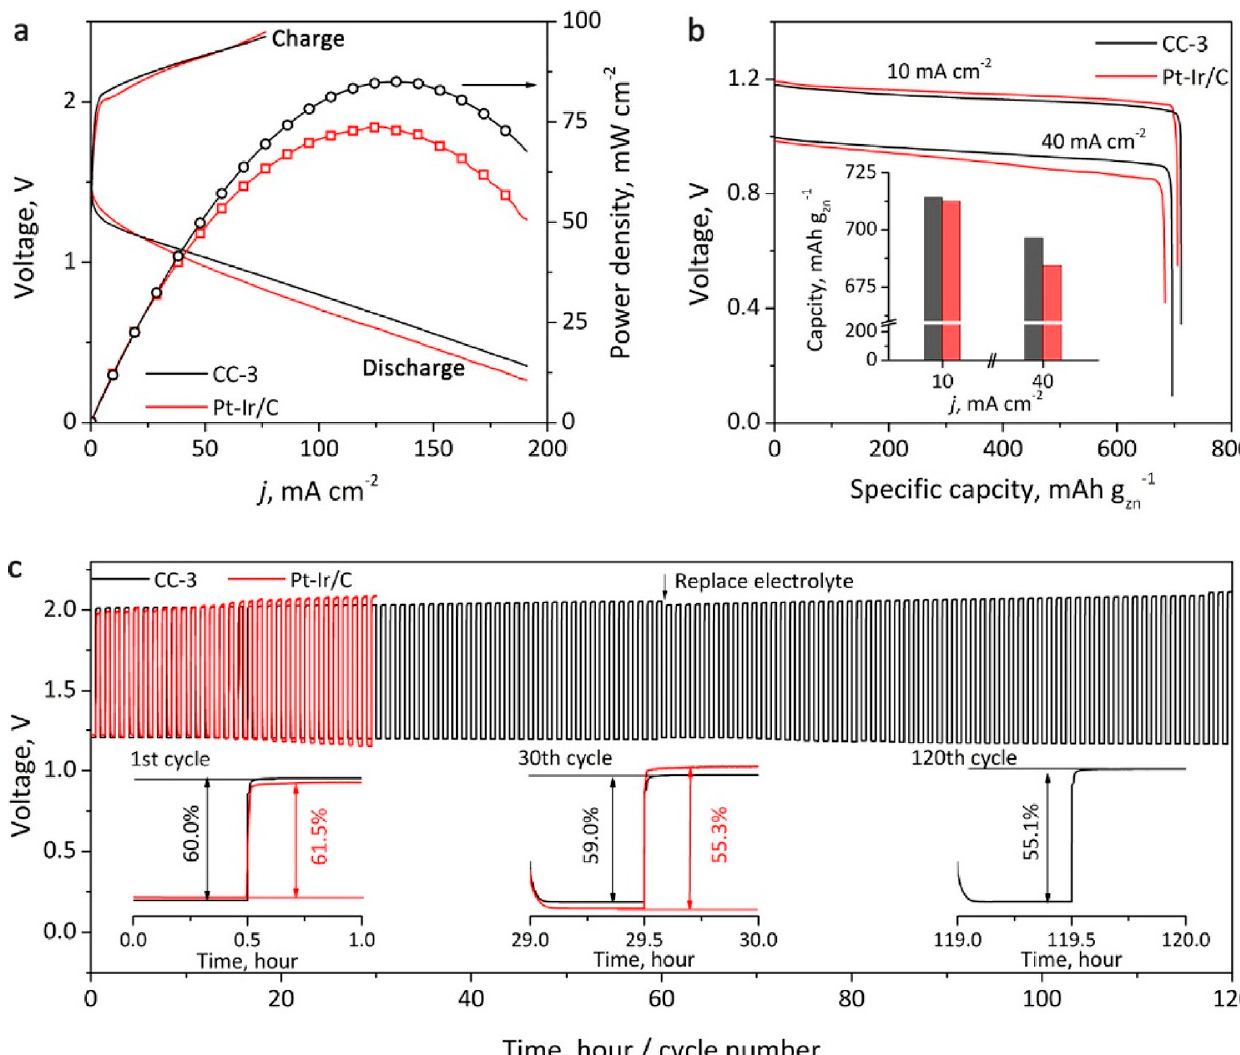
Figure 6. ( a ) Galvanodynamic charge/discharge profiles and power density and ( b ) galvanostatic discharge curve for rechargeable zinc–air batteries assembled using CC-3 and Pt–Ir/C oxygen catalysts. The inset shows the battery capacity under different discharge current densities. ( c ) Cycling profiles. The insets show cycling performances at 1st, 30th, and 120th cycles. Reprinted from [42] with permission from American Chemical Society Copyright © 2021.